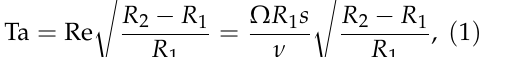
Figure 6. Reynolds number vs. speed for oil, ethanol, water and EMG 900 (Re c = 1100 to 1300). 3. Mathematical Model The equations that describe the flow of real fluids are an expression of the basic phys- ical conservation laws of mass and momentum. Physically, these laws express the balance of a quantity J (physical unit depends on the type of variable J ) in a given volume [25]. According to this balance, the time change of the preserved quantity in the given volume V is equal to the flow of this quantity through the area S , which circumscribes this volume, and its production within the volume V . (cid:3105) (cid:3105)(cid:3047) (cid:1516) 𝐽𝑑𝑉 (cid:3023) + (cid:1516) 𝐹 (cid:3037) (𝐽)𝑛 (cid:3037) 𝑑𝑆 (cid:3020) = (cid:1516) 𝑃(𝐽)𝑑𝑉 (cid:3023) , (7) where J is the balanced quantity, 𝐹 (cid:3037) (𝐽) is the j th component of the flow density vector of the quantity J by the area dS , 𝑛 (cid:3037) is the j th component of the normal vector and P (J) is the production density of the quantity J (production per unit time in volume V). For index j , Einstein ′ s summation rule is used. The flow of a quantity J is defined as the transfer of this quantity through a unit of area per unit time, e.g., mass flow and momentum flow. The three-dimensional model can be simplified in the case of piping systems to the two-dimensional axially symmetrical model. The defined mathematical model characterizes the flow of fluids in general spatial geometry, which is presented here by the internal space between two cylinders, where the inner one rotates. All boundary conditions on the rectangular area were of the wall type. The various rotational speeds from 10 rpm to 1000 rpm, in accordance with the physical